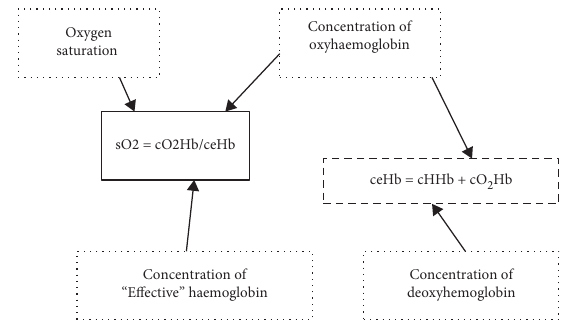
Figure 6: Oxygen saturation. ceHb (effective haemoglobin) ex- cludes the fractions of carboxy- and methemoglobin, which a blood gas analyzer cannot quantify accurately